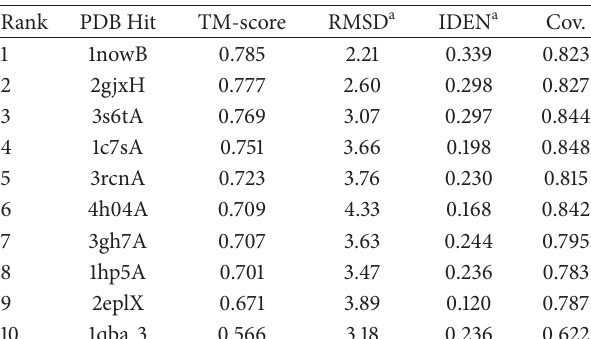
Table 2: Top 10 identified structural analogs in PDB by COFAC-